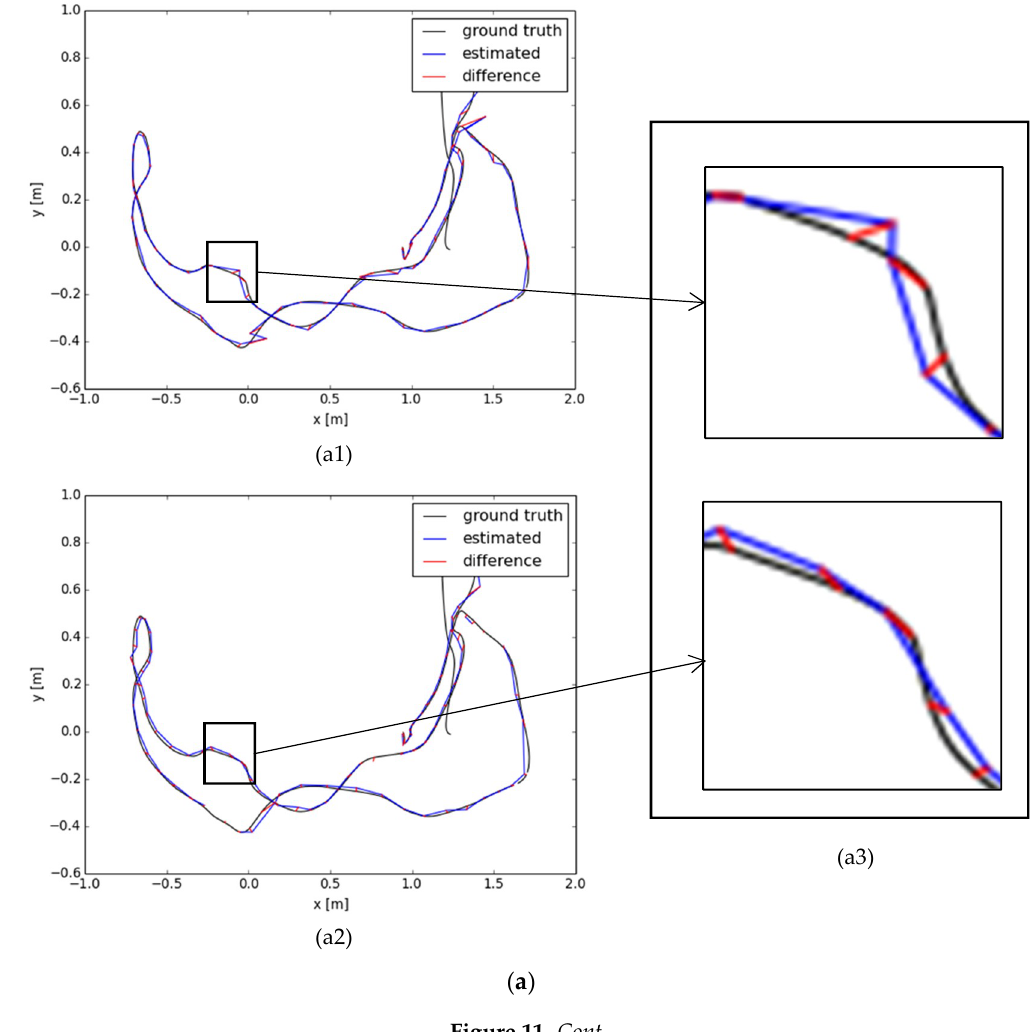
Figure 10. Performance comparison in terms of median of relative pose error using different values of k which indicates the number of training RGB images in a viewpoint class in our approach, and the stride to select the key-frames from the training datasets in other approaches. The test dataset is ‘freiburg1 desk’.